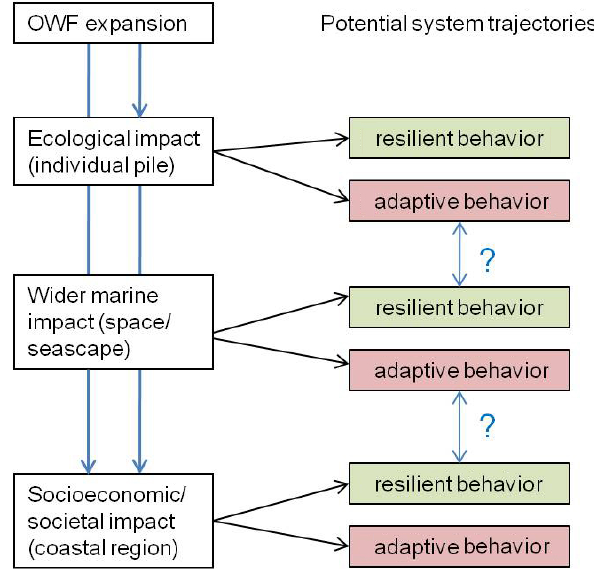
Fig. 3 . Conceptual model illustrating the linkages between the offshore wind farm (OWF) case study and the potential future system